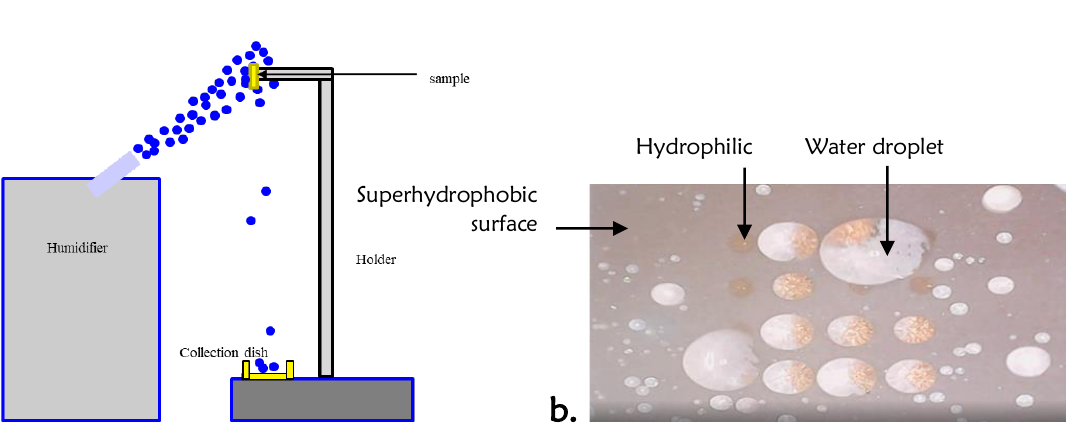
Figure 5: a. The schematic of the experiment's settings. b. water collection on the sample